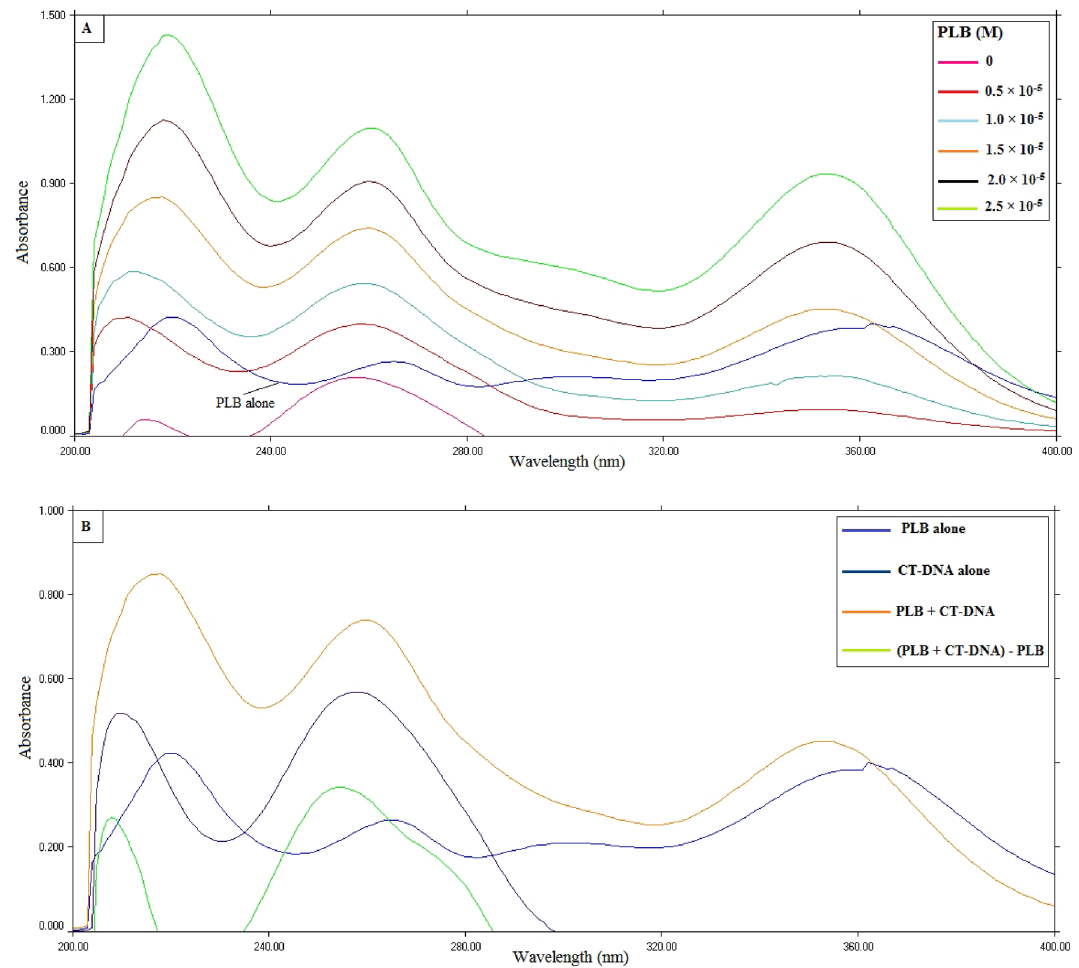
Figure 2. UV absorption spectra of ( A ) CT-DNA (8.25 × 10 −5 M) titrated with increasing concentrations of PLB (0–2.5 × 10 −5 M), ( B ) PLB alone, CT-DNA alone, PLB-CT-DNA complex, and the difference